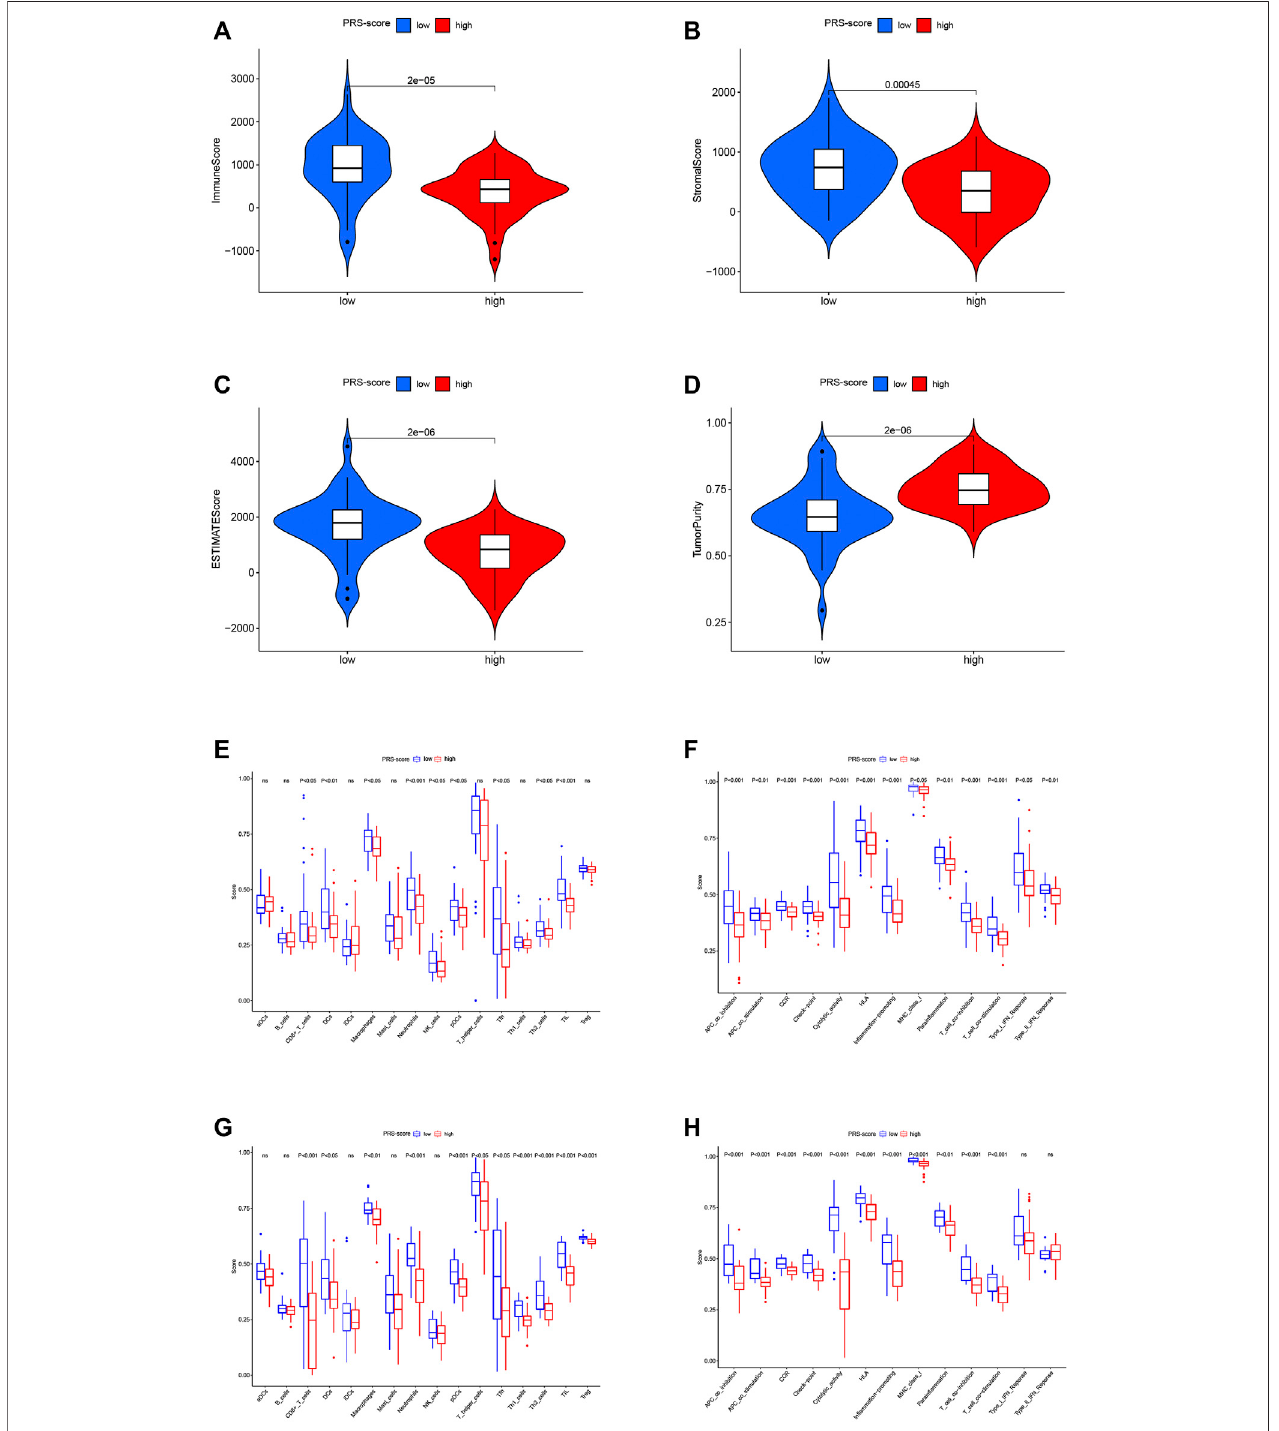
FIGURE8| Immunecharacteristicsanalysisoftheprognosticsignature. (A) ImmunescoresbetweenhighandlowPRS-scoregroups .(B) Stromalscoresbetween high and low PRS-score groups (C) ESTIMATE scores between high and low PRS-score groups. (D) Tumor purity between high and low PRS-score groups (E) Comparisons of thelevel ofimmunecell in fi ltration between high and lowPRS-score groups inthe TARGET cohort. (F) Comparisons ofimmune functionsbetween high and low PRS-score groups in the TARGET cohort. (G) Comparisons of the level of immune cell in fi ltration between high and low PRS-score groups in the GEO cohort. (H) Comparisons of immune functions between high and low PRS-score groups in the GEO cohort.